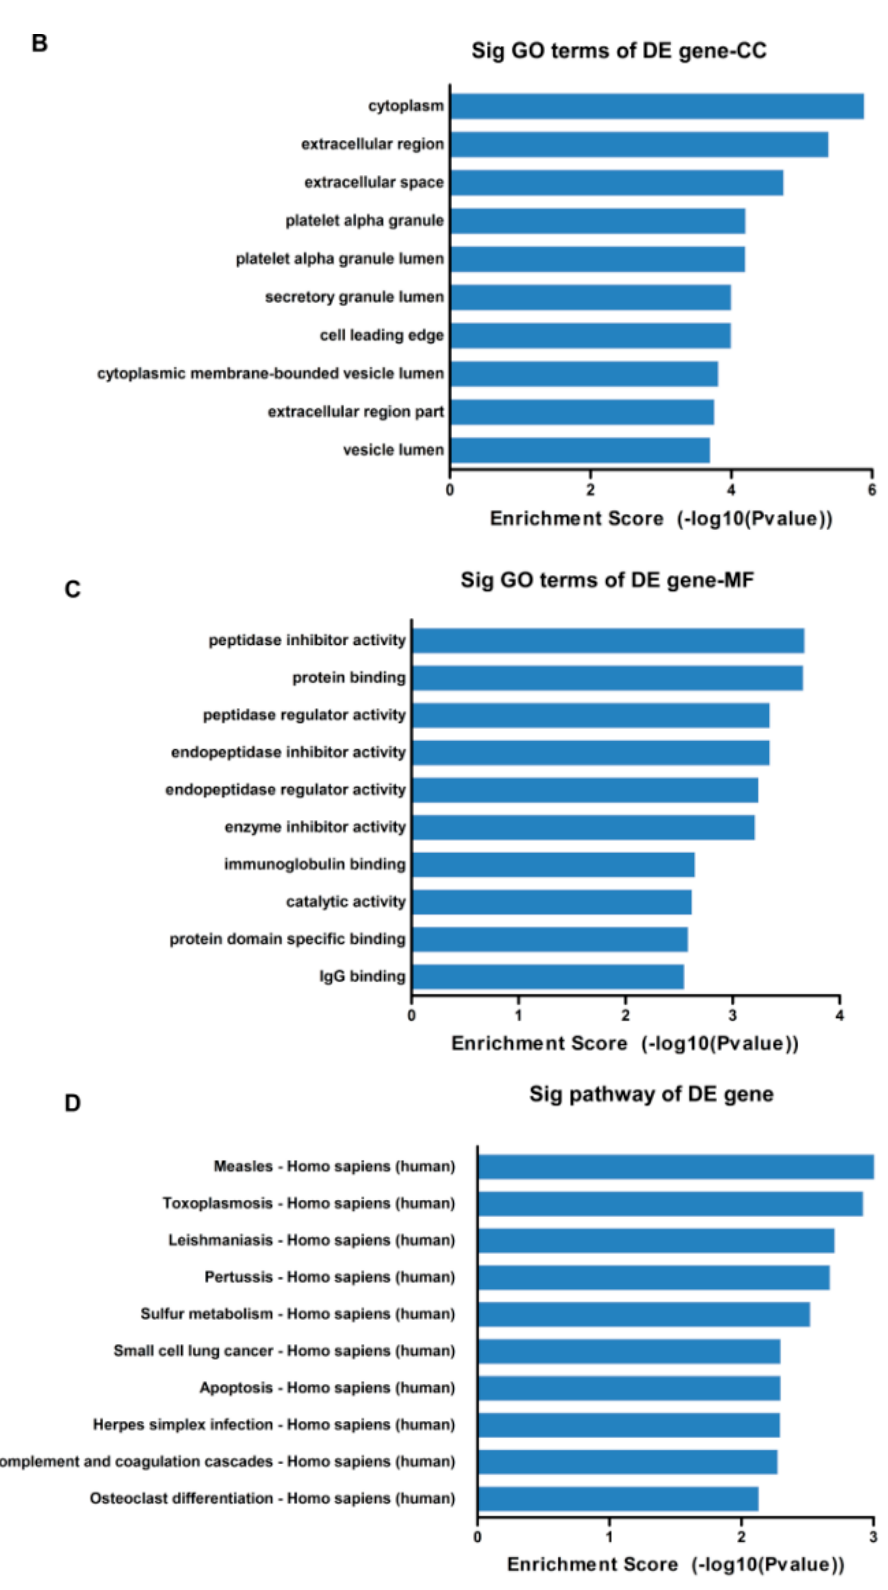
Figure 2. Gene ontology (GO) and pathway analysis of dysregulated genes in high metastatic potential NPC cell lines when compared with low metastatic potential NPC cell lines. ( A – C ) the top ten enrichment score ( − log10 ( p -value)) values for significantly enriched GO terms including Biological Process ( A ), Cellular Component ( B ) and Molecular Function ( C ), and ( D ) the top ten highest and significant pathways. p -Values were calculated using the significance test ( A – C ) and Fisher’s exact test ( D